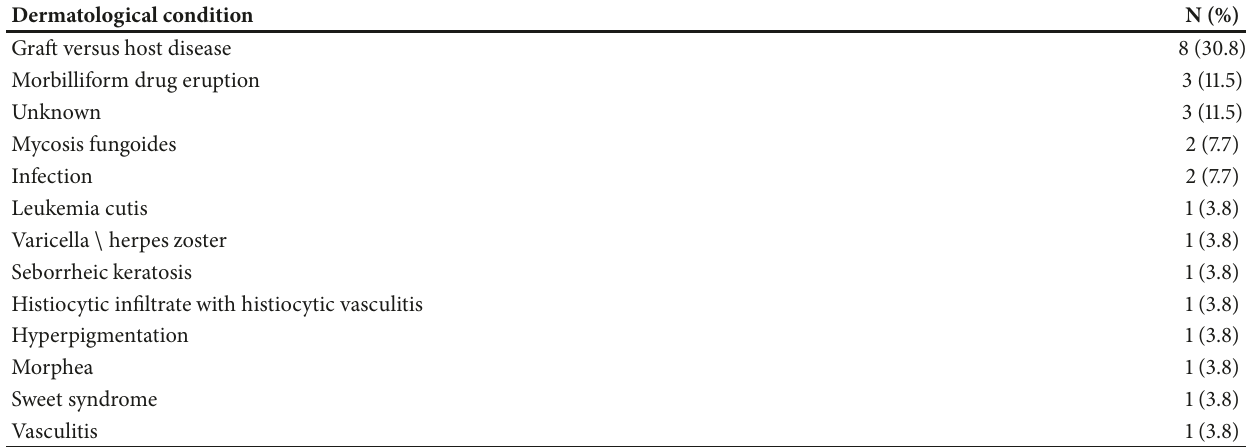
Table 3: Dermatological diseases diagnosed in hematology inpatients confirmed by skin biopsy. Dermatological condition Graft versus host